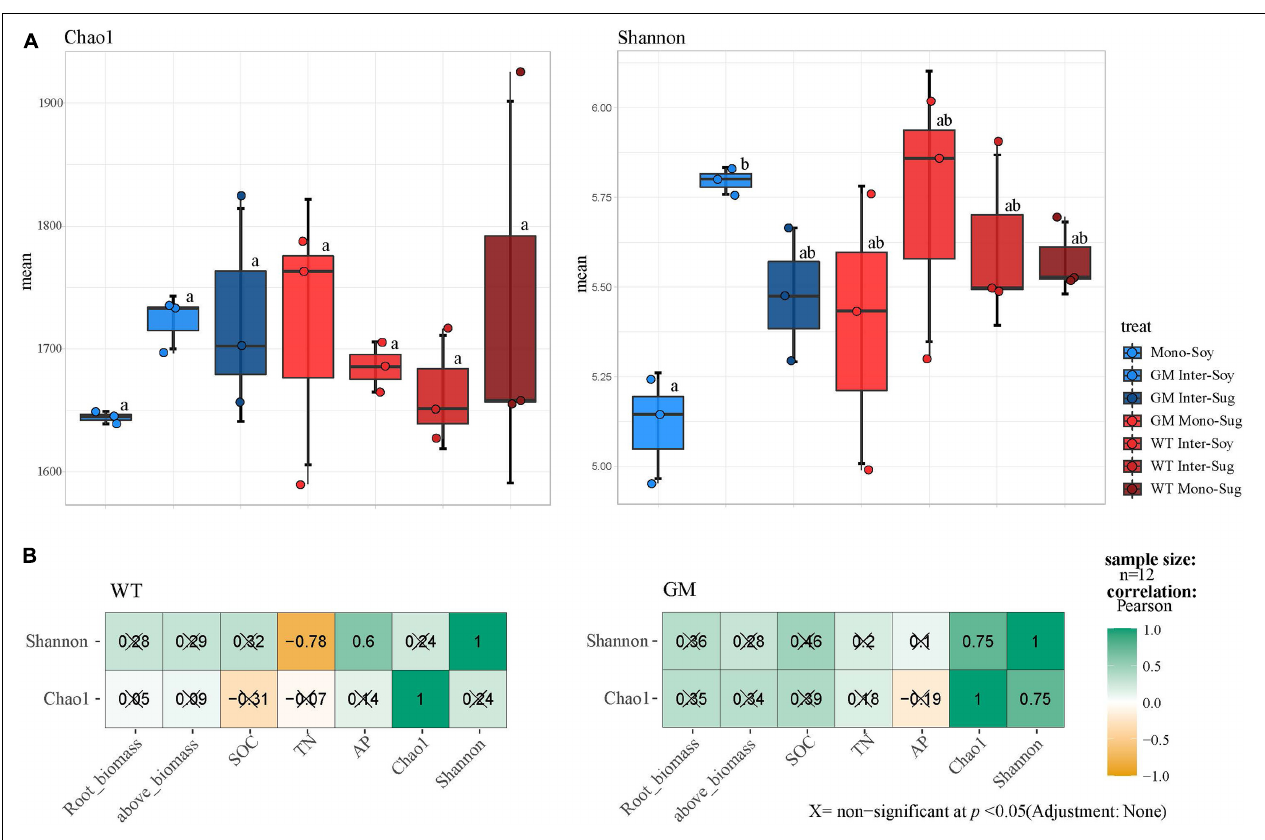
FIGURE 2 | (A) The results of Chao 1 index and Shannon index showed the α -diversity of bacteria. F, Fisher’s F-ratio. p , p -value. The letters next to the bar chart indicate the significant differences between the processed data. (B) Pearson analysis of the correlation between bacterial α -diversity and environmental